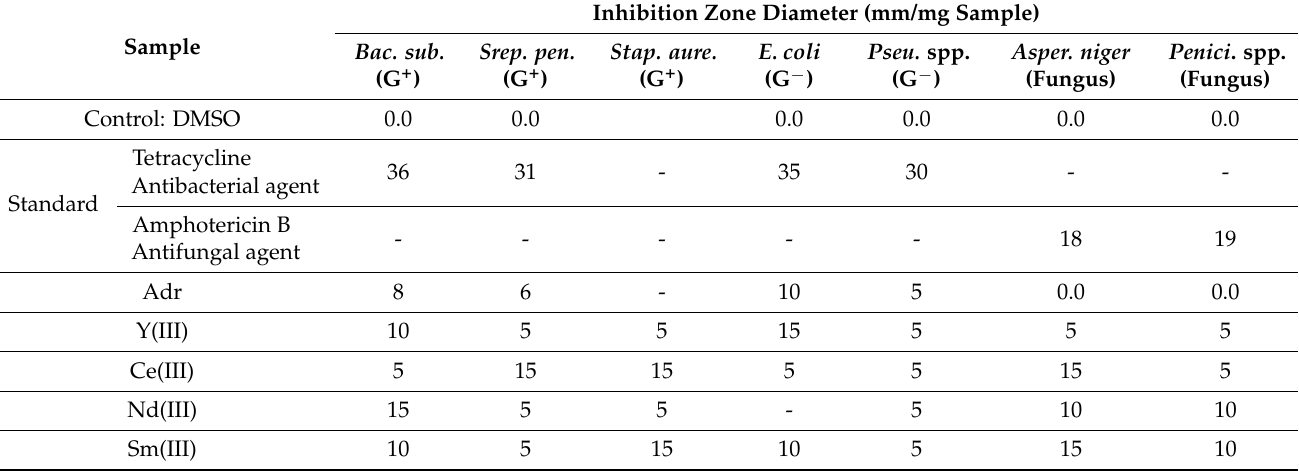
Table 2. Adrenaline and its adducts’ inhibition zone diameter (mm/mg